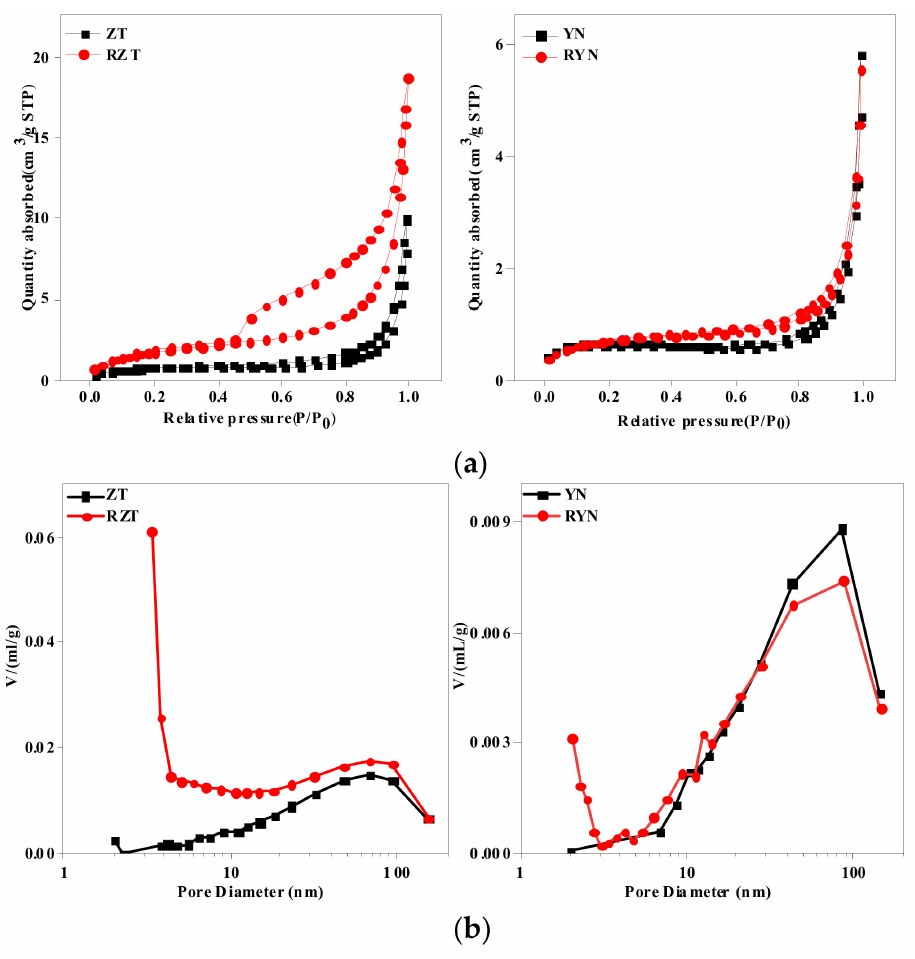
Figure 7. Nitrogen adsorption-desorption isotherms ( a ) and pore size distribution ( b ) of coal